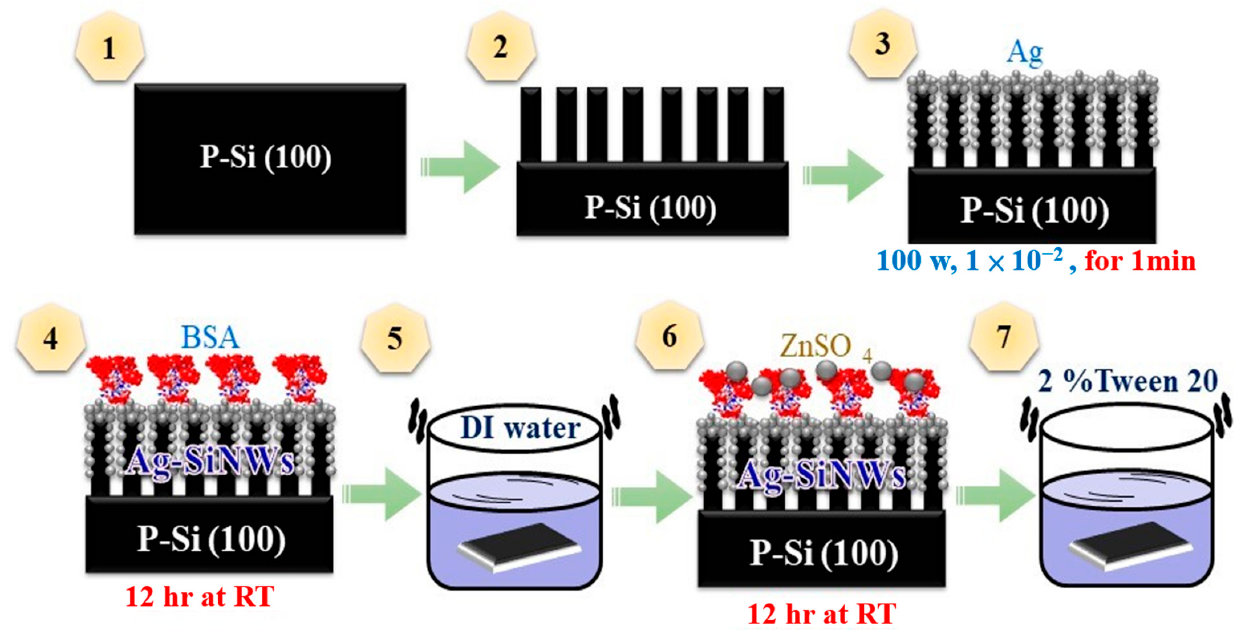
Figure 1. Procedure for the functionalization of SiNW arrays with Ag by RF magnetron sputtering, the immobilization of bovine serum albumin (BSA), and the detection of heavy metal ion Zn 2+ on the Ag-modified SiNW arrays. Step description: (1). In order to remove chemical impurities and particles, the wafers were cleaned by a standard Radio Corporation of American (RCA) cleaning process. (2). SiNW arrays were synthesized at the AgNO 3 /HF solution for 30 min at 75 °C by Ag-assisted electroless etching. (3). Ag nanoparticles were deposited onto p-SiNWs by RF magnetron sputtering for 1 min at 100 °C. (4). The BSA protein was immobilized on the Ag–SiNW arrays for 12 h at room temperature. (5). After washing thoroughly with double-distilled water (ddH 2 O) three times to remove excess BSA, the samples were dried at room temperature. (6). Then, ZnSO 4 was coated onto the treated modified SiNW arrays and incubated for 12 h. (7). Following three washes with washing buffer (0.1% Tween 20), to remove unbounded ZnSO 4 , the sample was dried again and ZnSO 4 immobilized SiNW arrays were